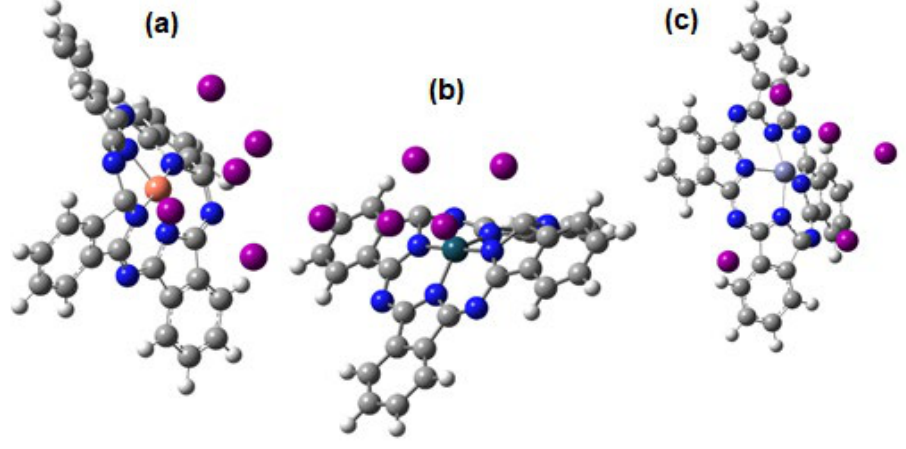
Figure 2. Complexes of phtalocyanine iodine (five atoms) ( a ) Cu, ( b ) Co and ( c ) Zn.